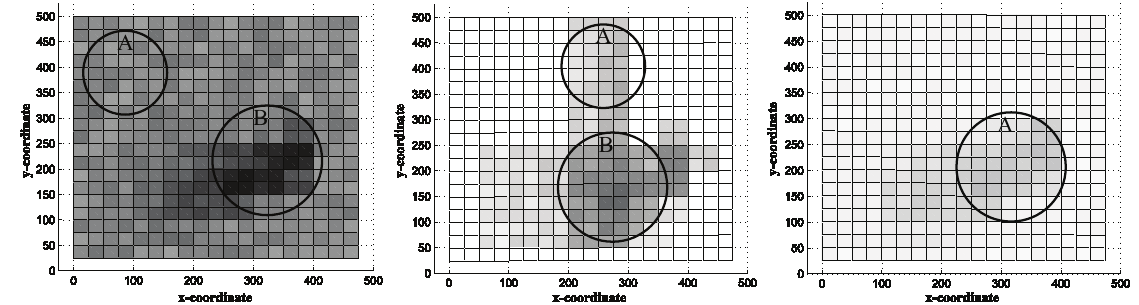
Figure 18. Distribution of energy consumption in TTDD ( left ), LBDD ( center ), OCOT ( right